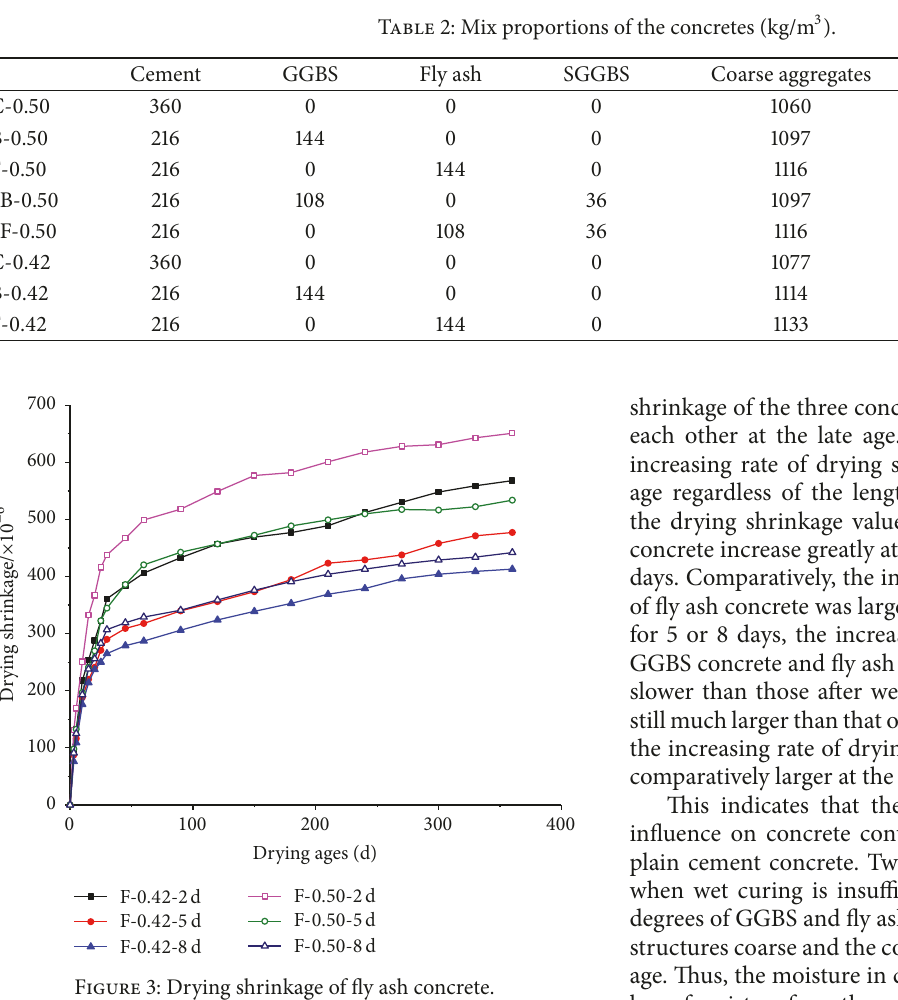
Figure 3: Drying shrinkage of fly ash